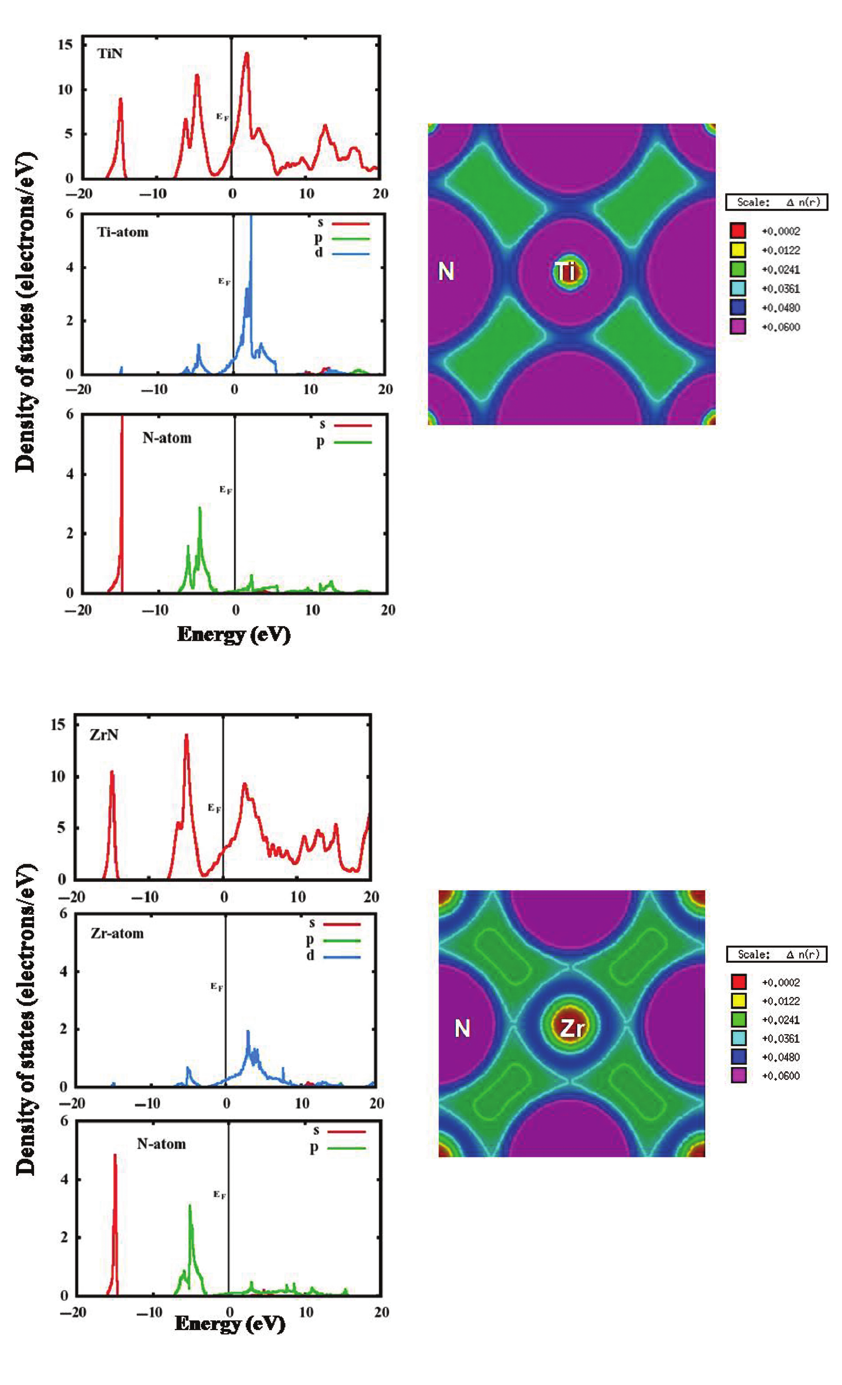
Figure 4: Electronic DOS and 2D charge density of ZrN.